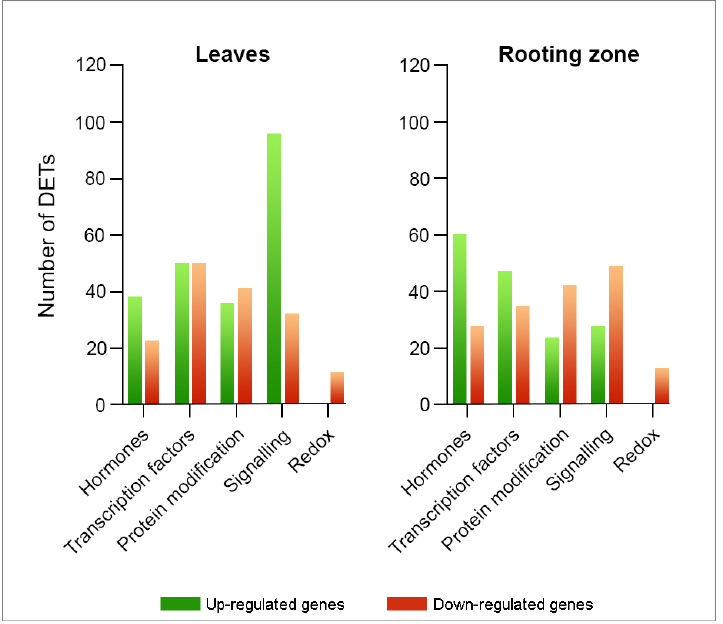
Figure 5. Transcriptomic profile modifications linked to hormone metabolism, signaling, and redox in E. nitens leaves and stem bases after three/four days of IBA-treatment. Fold-change ≥ 2 and FDR < 0.05.